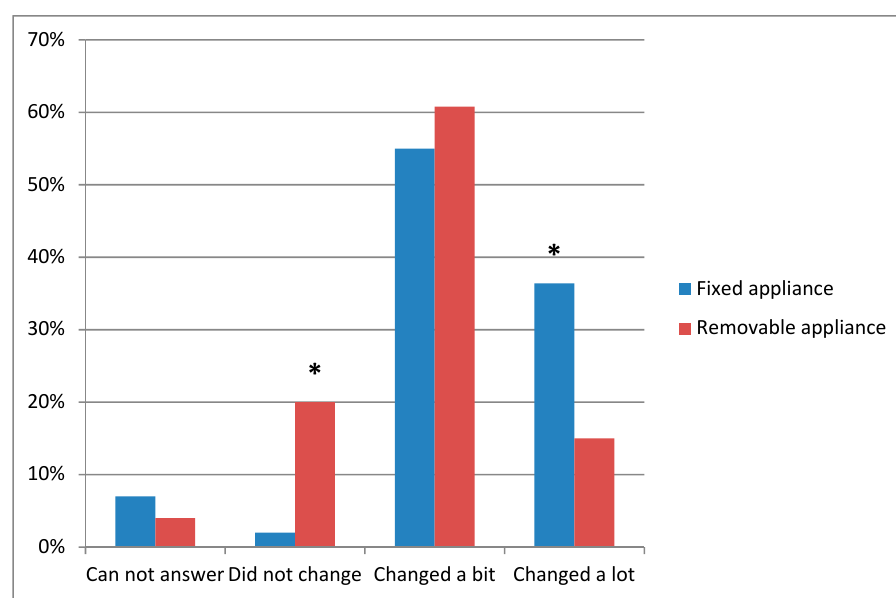
Figure 1. Changes in oral hygiene habits among patients receiving orthodontic treatment. Chi-square test, comparing results by di ff erent type of receiving orthodontic treatment (fixed and removable appliances); * —statistically significant di ff erences ( p =